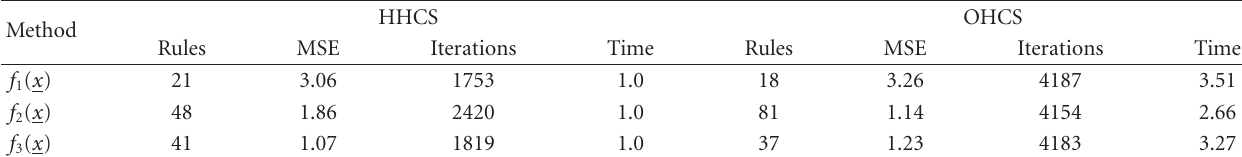
Table 1: Comparison between HHCS and OHCS for di ff erent approximation problems.